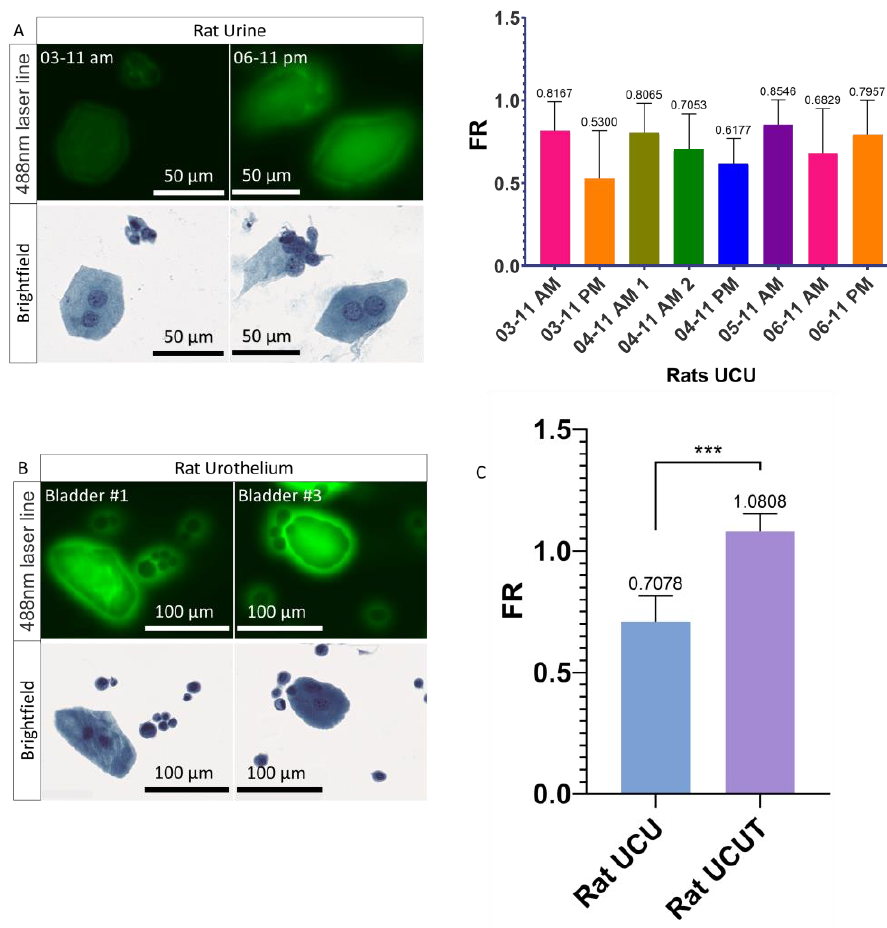
Figure 3. Fluorescence and PMF of UCUs and UCUTs. ( A ) Images acquired on the scanner of UCUs and quantification of their PMF. Three to 5 rats were pooled by sample. ( B ) Images acquired on the scanner of UCUTs. ( C ) Quantification of the PMF of UCUs versus UCUTs. Bar graphs represent the mean (SD) (*** p <0.001).